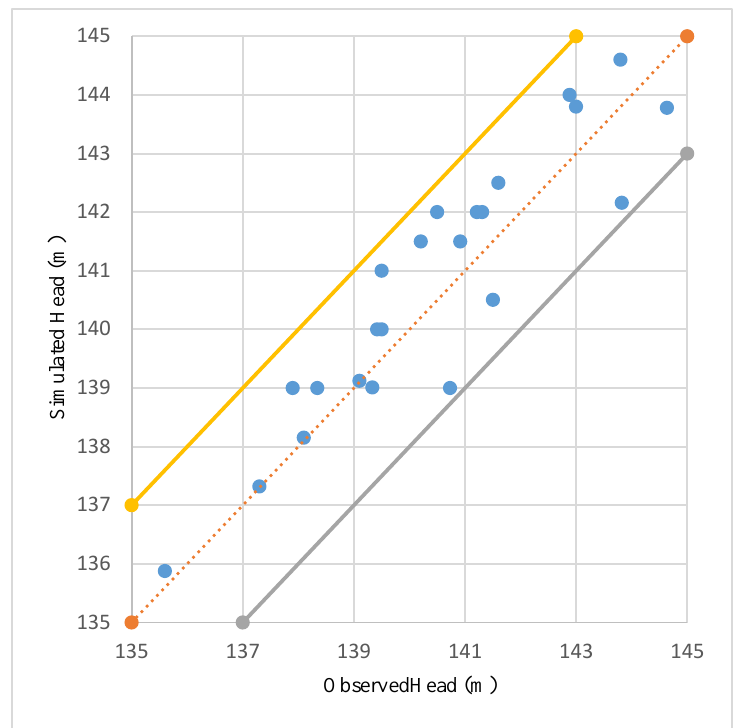
Figure 6. Model Validation Graph.